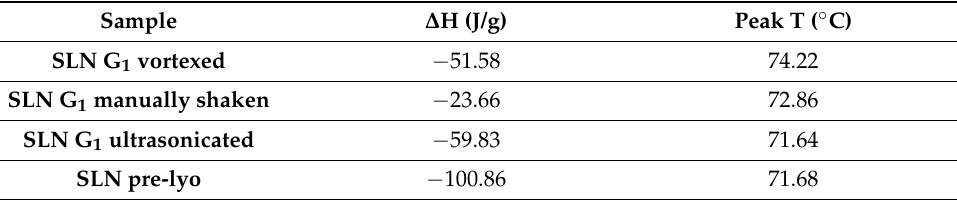
Figure 8. DSC thermograms of SLN G1, resuspended with three different methods, compared to pre-lyophilization SLN. Pre-lyophilization SLN (black); ultrasonicated SLN G1 (red); manually shaken SLN G1 (blue); vortexed SLN G1 (yellow). Table 6. Enthalpy variations ( ∆ H) and peak temperatures of resuspended SLNs with various methods and pre-lyophilization SLN.